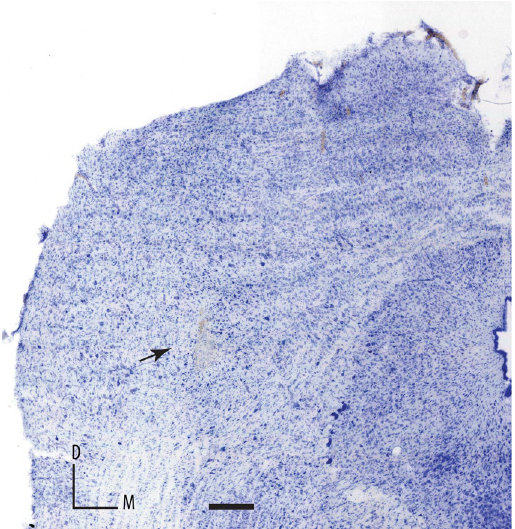
Figure 1. Photomicrograph of a coronal section through the rostral cortex of the IC showing a typical electrolytic lesion of a recording site for a neuron with a high CSI value. Scale bar, 1 mm. M, medial; D,